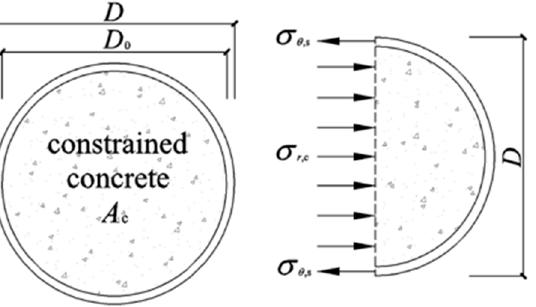
Figure 11. Simplified stress distribution model at the mid-height section of CFCST stub columns.